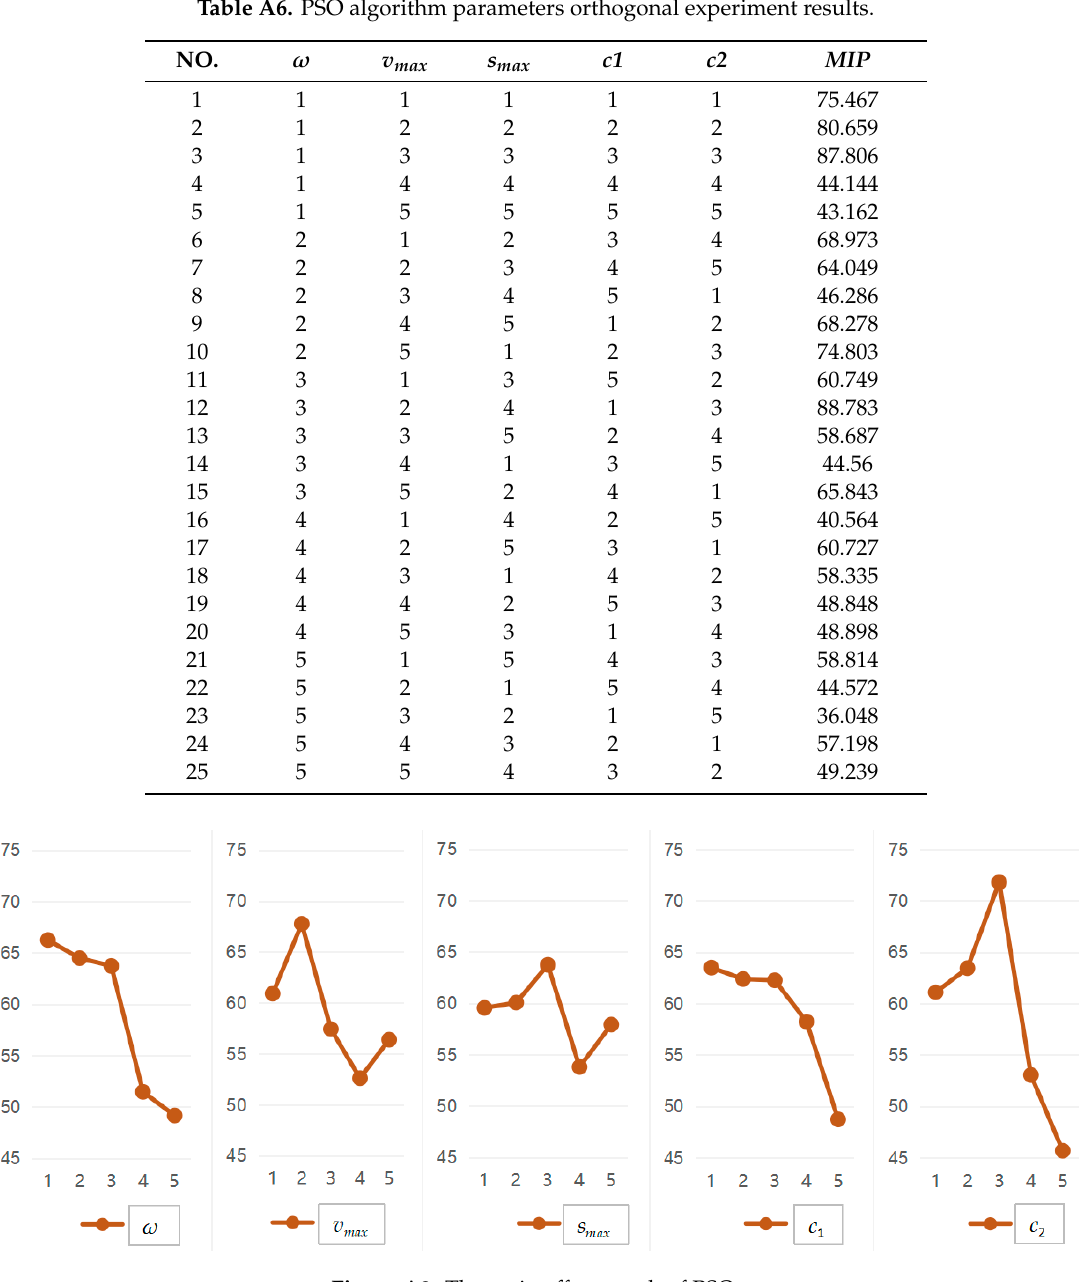
Figure A3. The main effect graph of PSO.